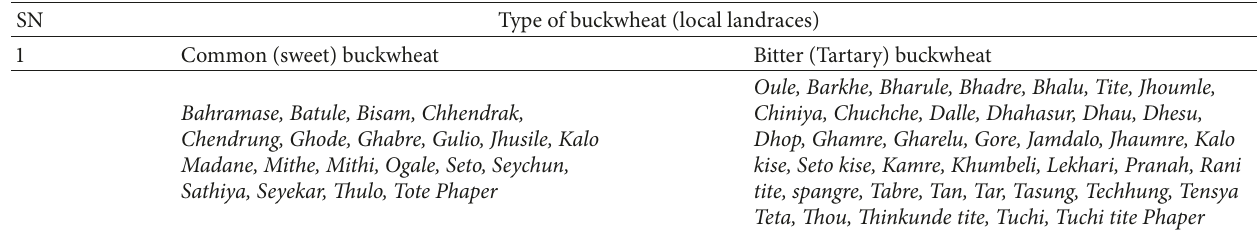
Table 1: Local names of common and bitter buckwheat in